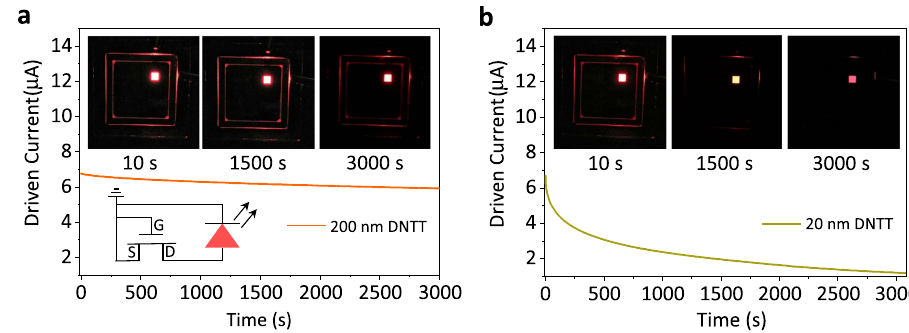
Fig. 5 Potential application of the ultrastable OFET. The driven current of a the 200 nm and b 20 nm DNTT OFETs versus time. The upper insets in a and b are pictures of the OLED driven by DNTT devices at different times. The bottom inset in a is the circuit diagram of the OLED driven by the DNTT OFET. G, S, and D indicate the gate electrode, source electrode, and drain electrode, respectively. The brightness of the OLED driven by the 200 nm DNTT OFET shows no visible change during the long-term operation, while it decays to a very weak value for the OLED driven by the 20 nm DNTT OFET. The bias was set as V GS = − 80 V and V DS = −